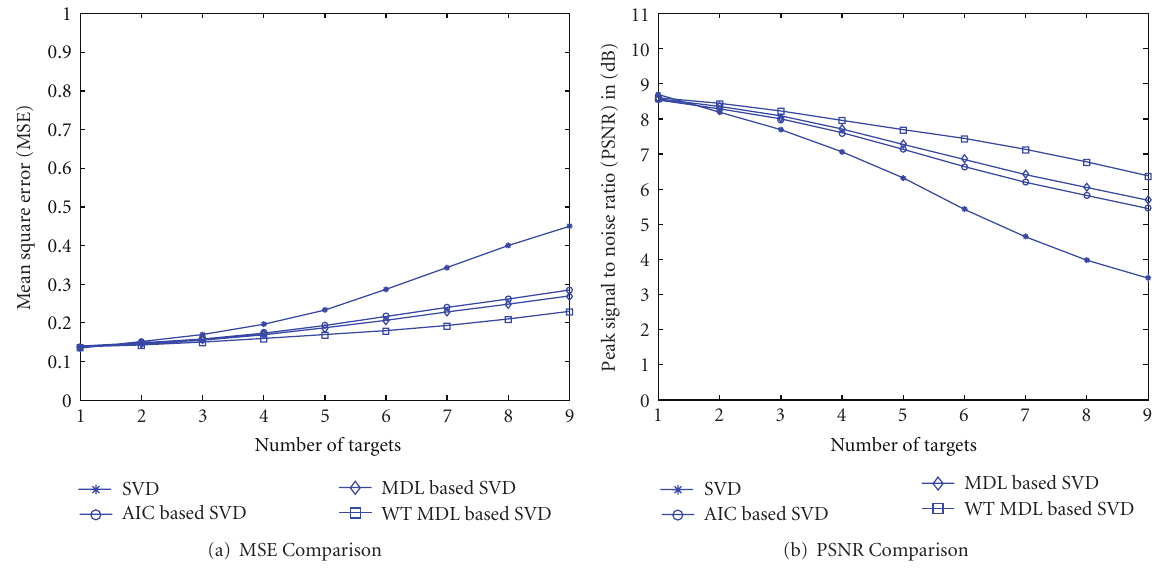
Figure 19: MSE and PSNR comparison of conventional and proposed schemes against number of